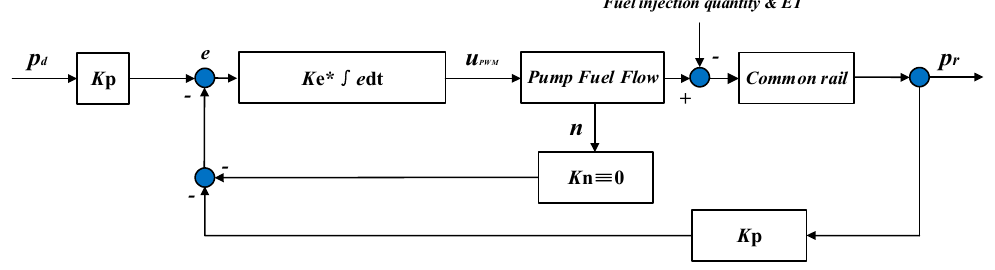
Figure 9. Control principle of PID optimized by optimal control.